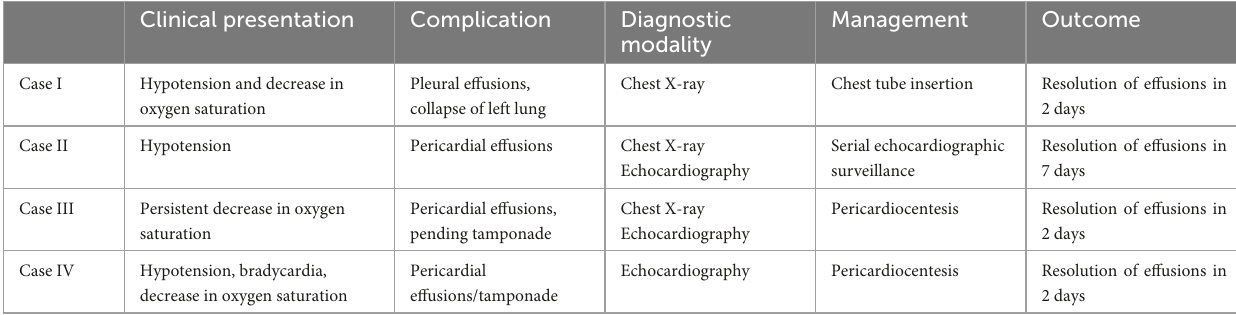
TABLE 2 Characteristics of complications related to neonatal